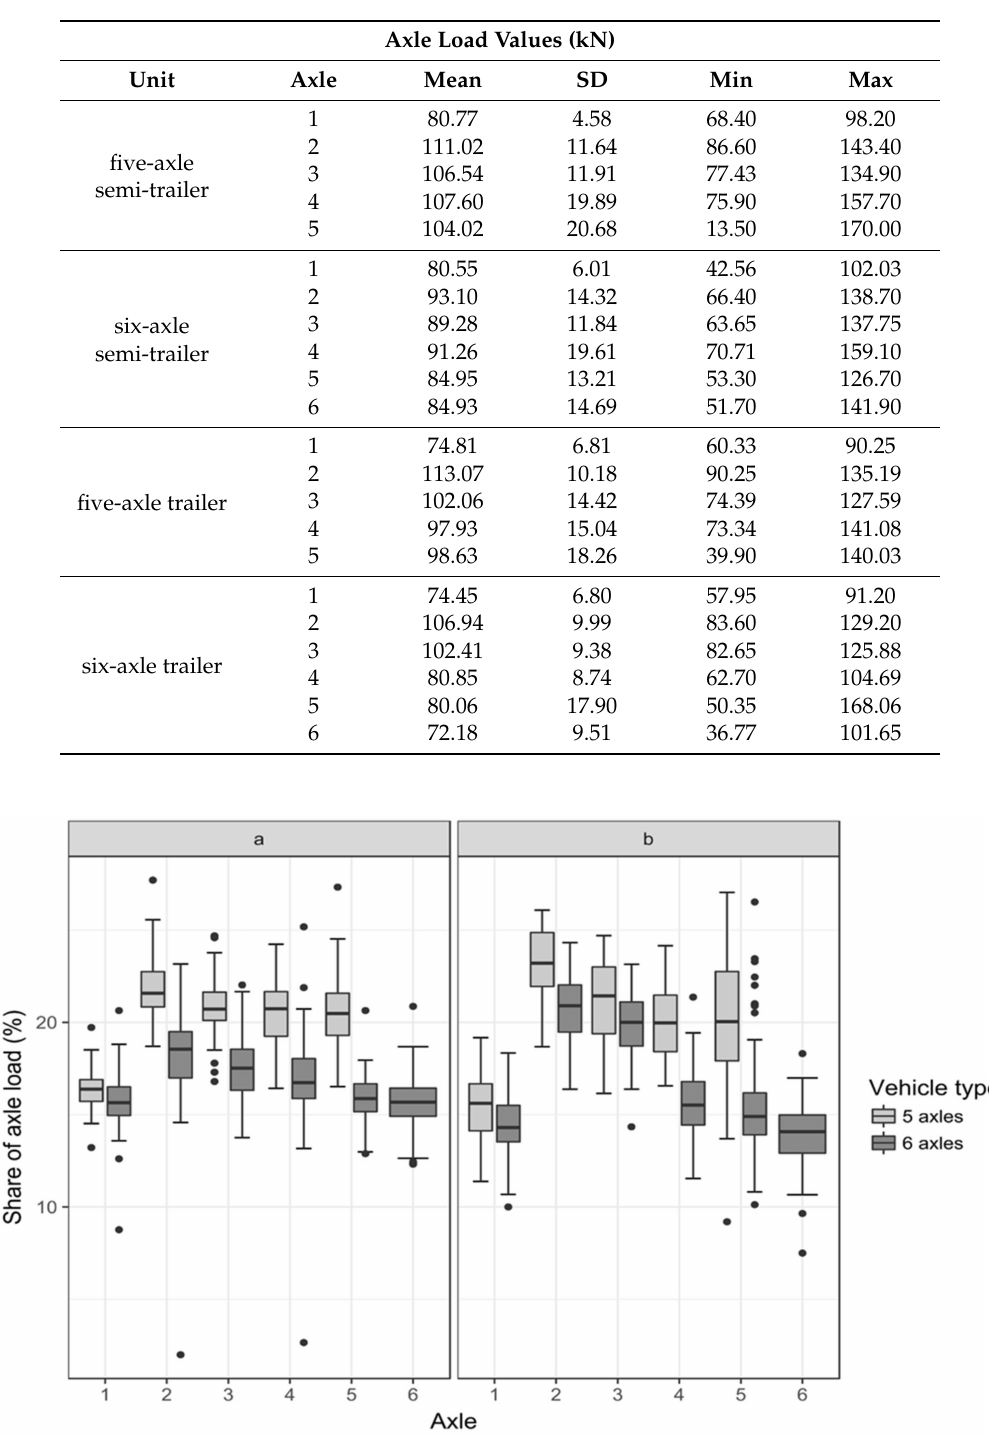
Table 6. Assessment of the model parameters for trailers.